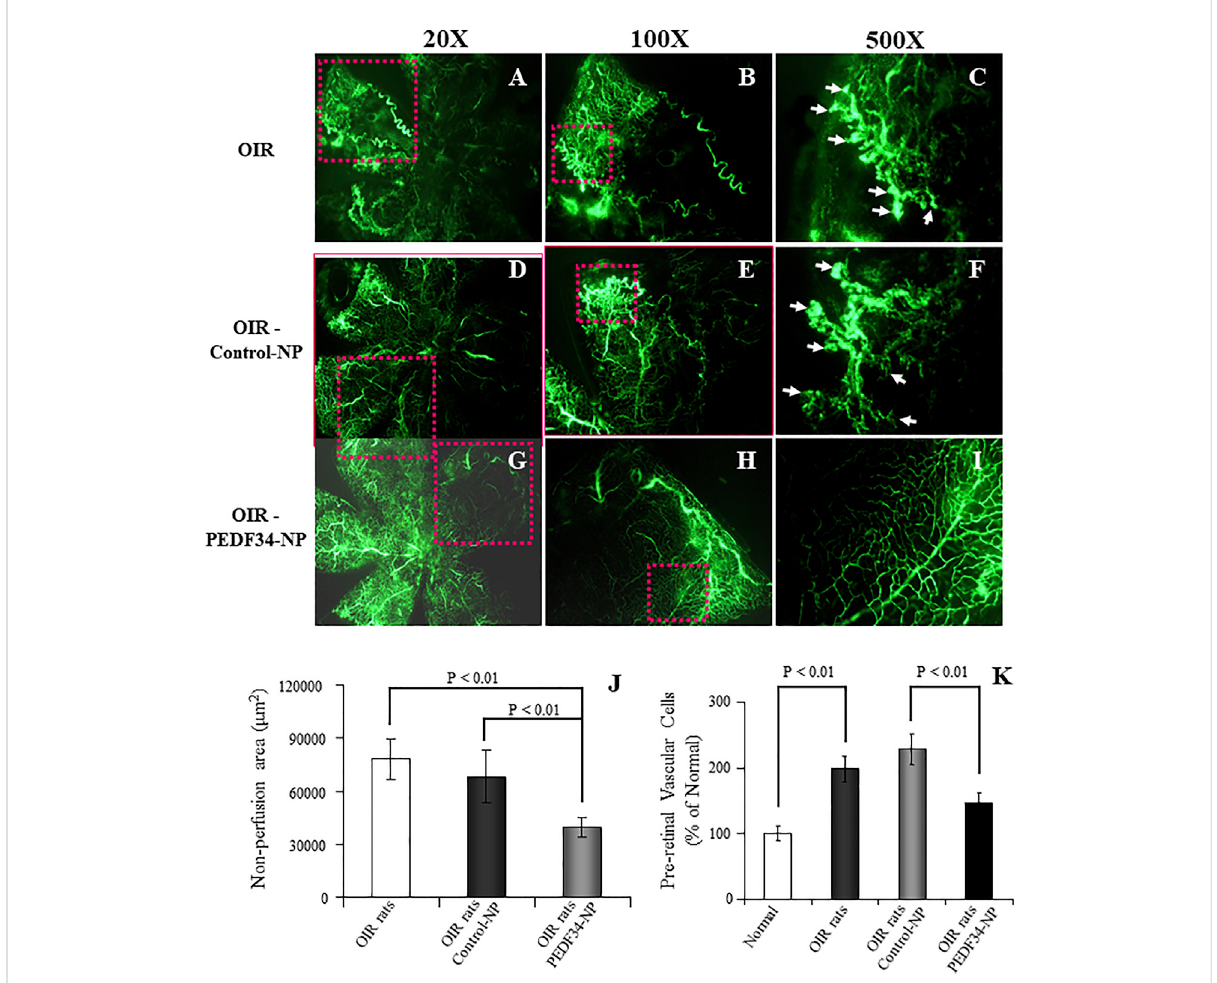
FIGURE 2 InhibitoryeffectsofPEDF34-NPonischemia-inducedretinalneovascularization.Ratswereexposedto75%±2%oxygenfromP7toP12.Retinal vasculature was examined using fl uorescein angiography at P18 as described in Methods. (A – C) OIR rats without treatment; (D – F) OIR rats injected with Control-NP (5 µg/eye); (G – I) OIR rats injected with PEDF34-NP into the vitreous (5 µg/eye) at P12. (J) Non-perfusion area was measured and expressed as percent of the total retina area (mean ± SD, n = 6). (K) At P18, the eyes were fi xed, sectioned and stained with hematoxylin and eosin (H&E). Pre-retinal vascular cells were counted in eight non-continuous sections per eye and averaged as described in Methods (mean ± SD, n =